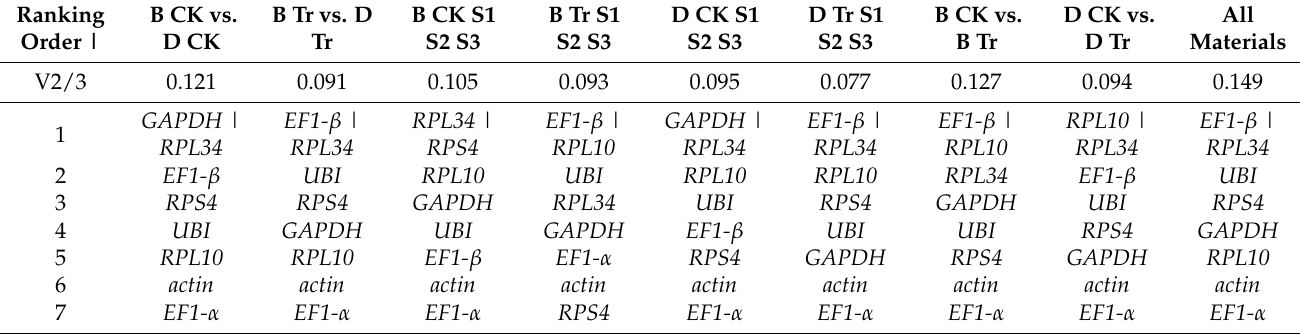
Table 3. Rank of candidate and Pairwise variation (V) of reference genes were calculated by geNorm.